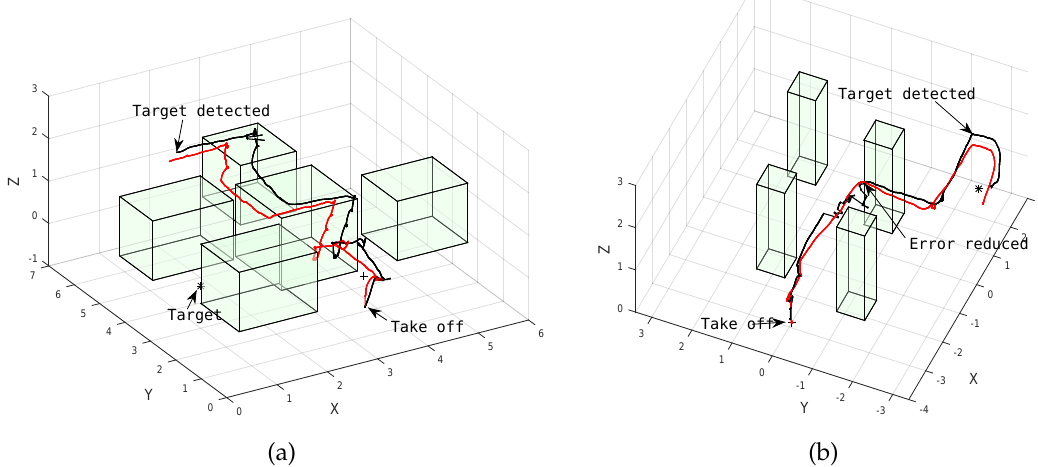
Figure 8. Comparison of onboard computed position (red) vs. the VICON positioning system (black). ( a ) Without resetting position error; ( b ) resetting position error with AR